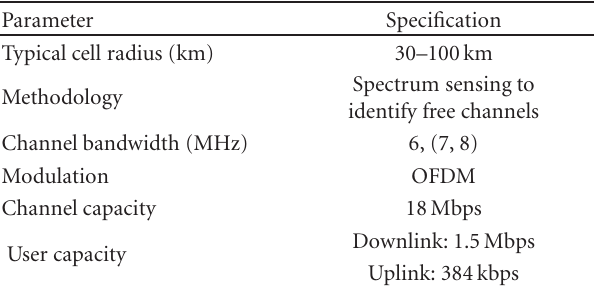
Table 1: IEEE 802.22